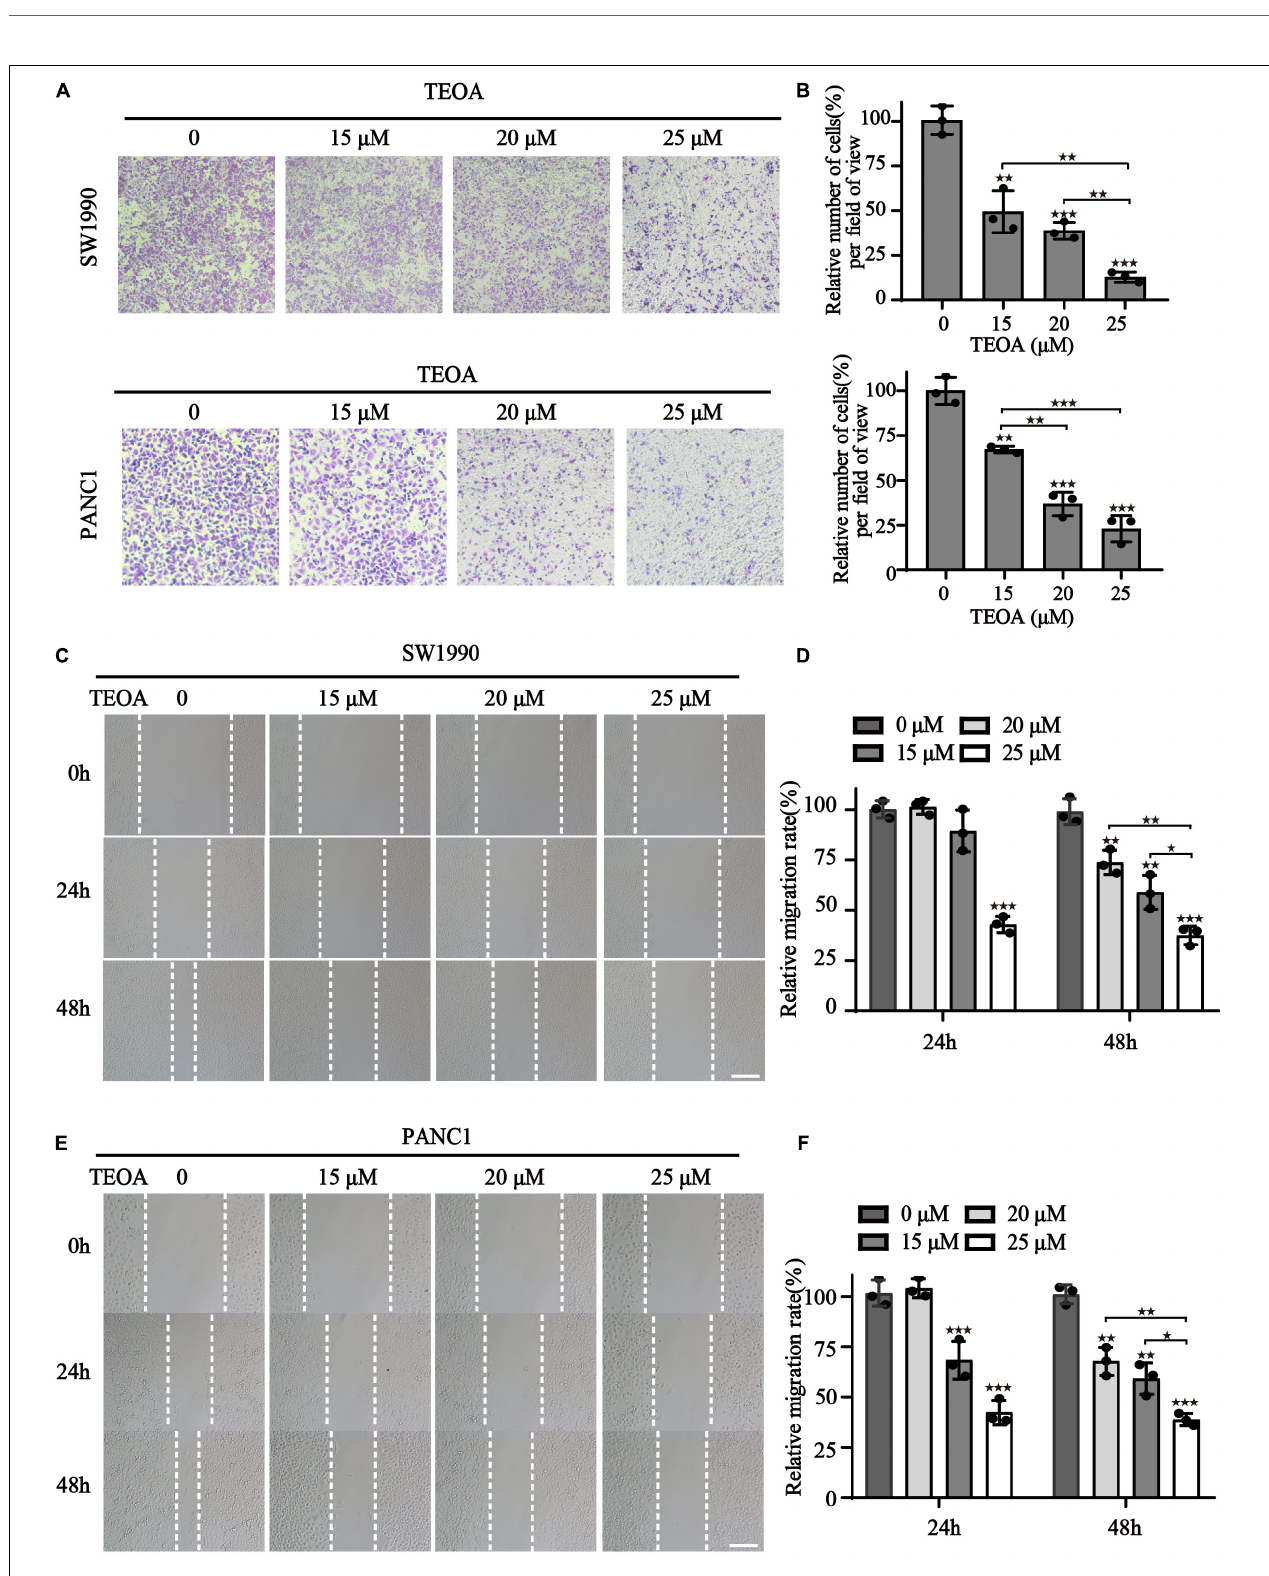
FIGURE 2 | TEOA suppressed migration of SW1990 and PANC1 cells. (A) Migration of PANC1 and SW1990 cells treated with 0, 15, 20, 25 µ M TEOA for 24 h was determined using the transwell assay. (B) Statistical analysis of the migration cells. (C–F) Scratch wound healing assay was used to detect the migration capability of cells with the indicated concentrations of TEOA and representative microscopic images were showing in the (C,E) . Relative migration distance was quantified and shown on the right ( (cid:70) p < 0.05; (cid:70)(cid:70) p < 0.01; (cid:70)(cid:70)(cid:70) p < 0.001, versus control).